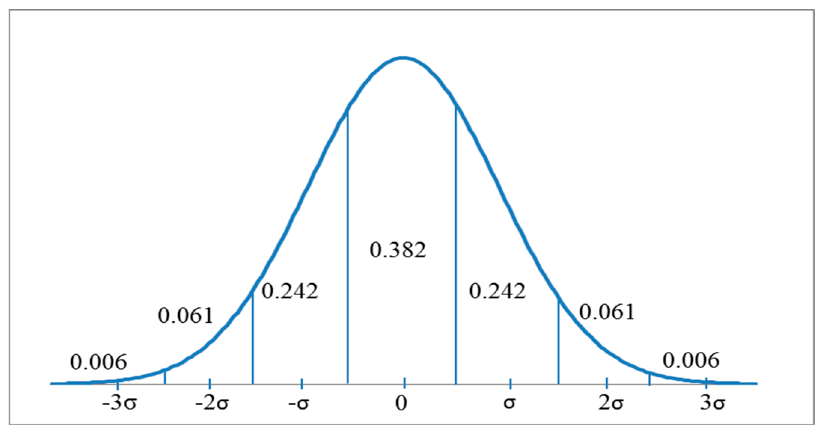
Figure 5. NLFE t and VGFE t distribution. A normal distribution was described using a seven-step approximation.